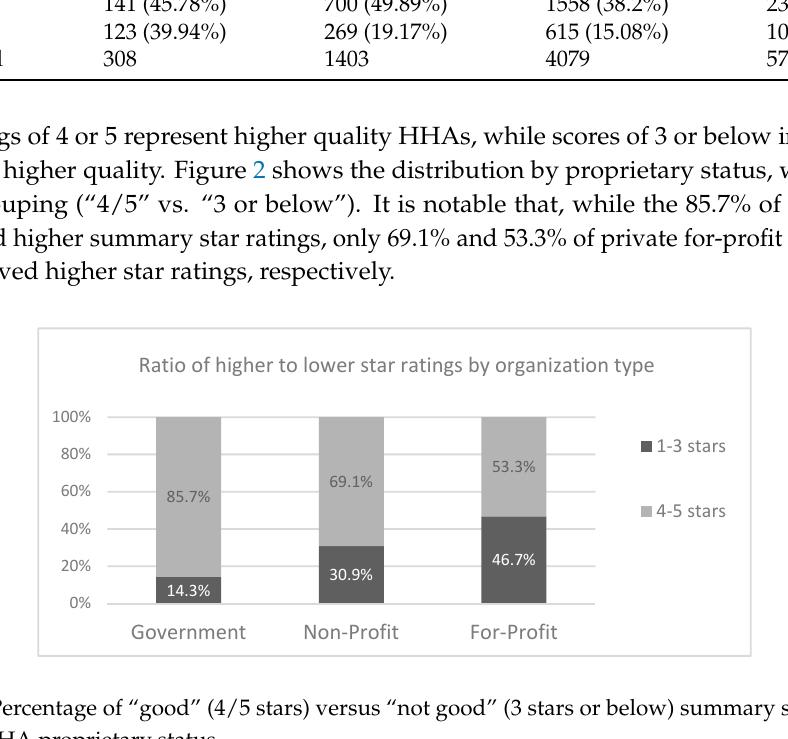
Figure 2. Percentage of “good” (4/5 stars) versus “not good” (3 stars or below) summary star ratings for each HHA proprietary status.